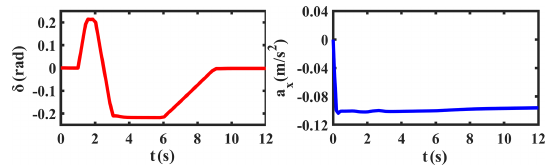
Figure 13. The obtained δ and a x under fishhook manoeuver test II.